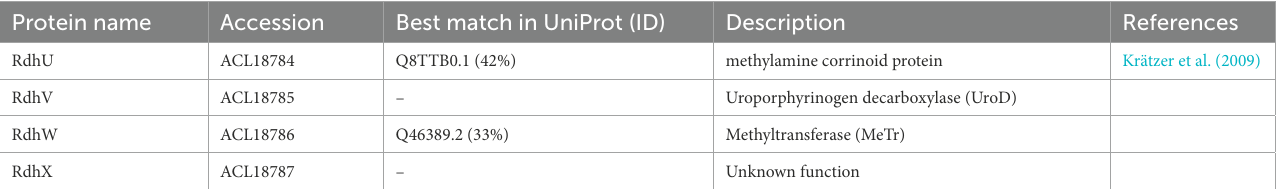
TABLE 3 Sequence analysis of newly assigned Rdh